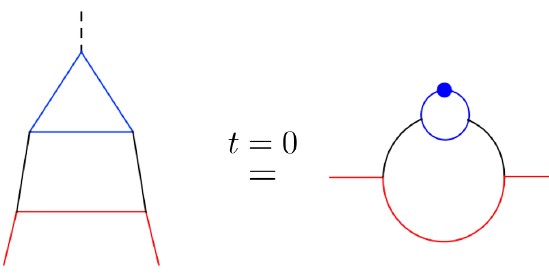
Figure 7. Diagrammatic representation of the q µ → 0 limit for the one-body scalar form factor, . At zero momentum transfer, no momentum flows into the diagram through the dashed line, F 1b S which just corresponds to the insertion of Λ